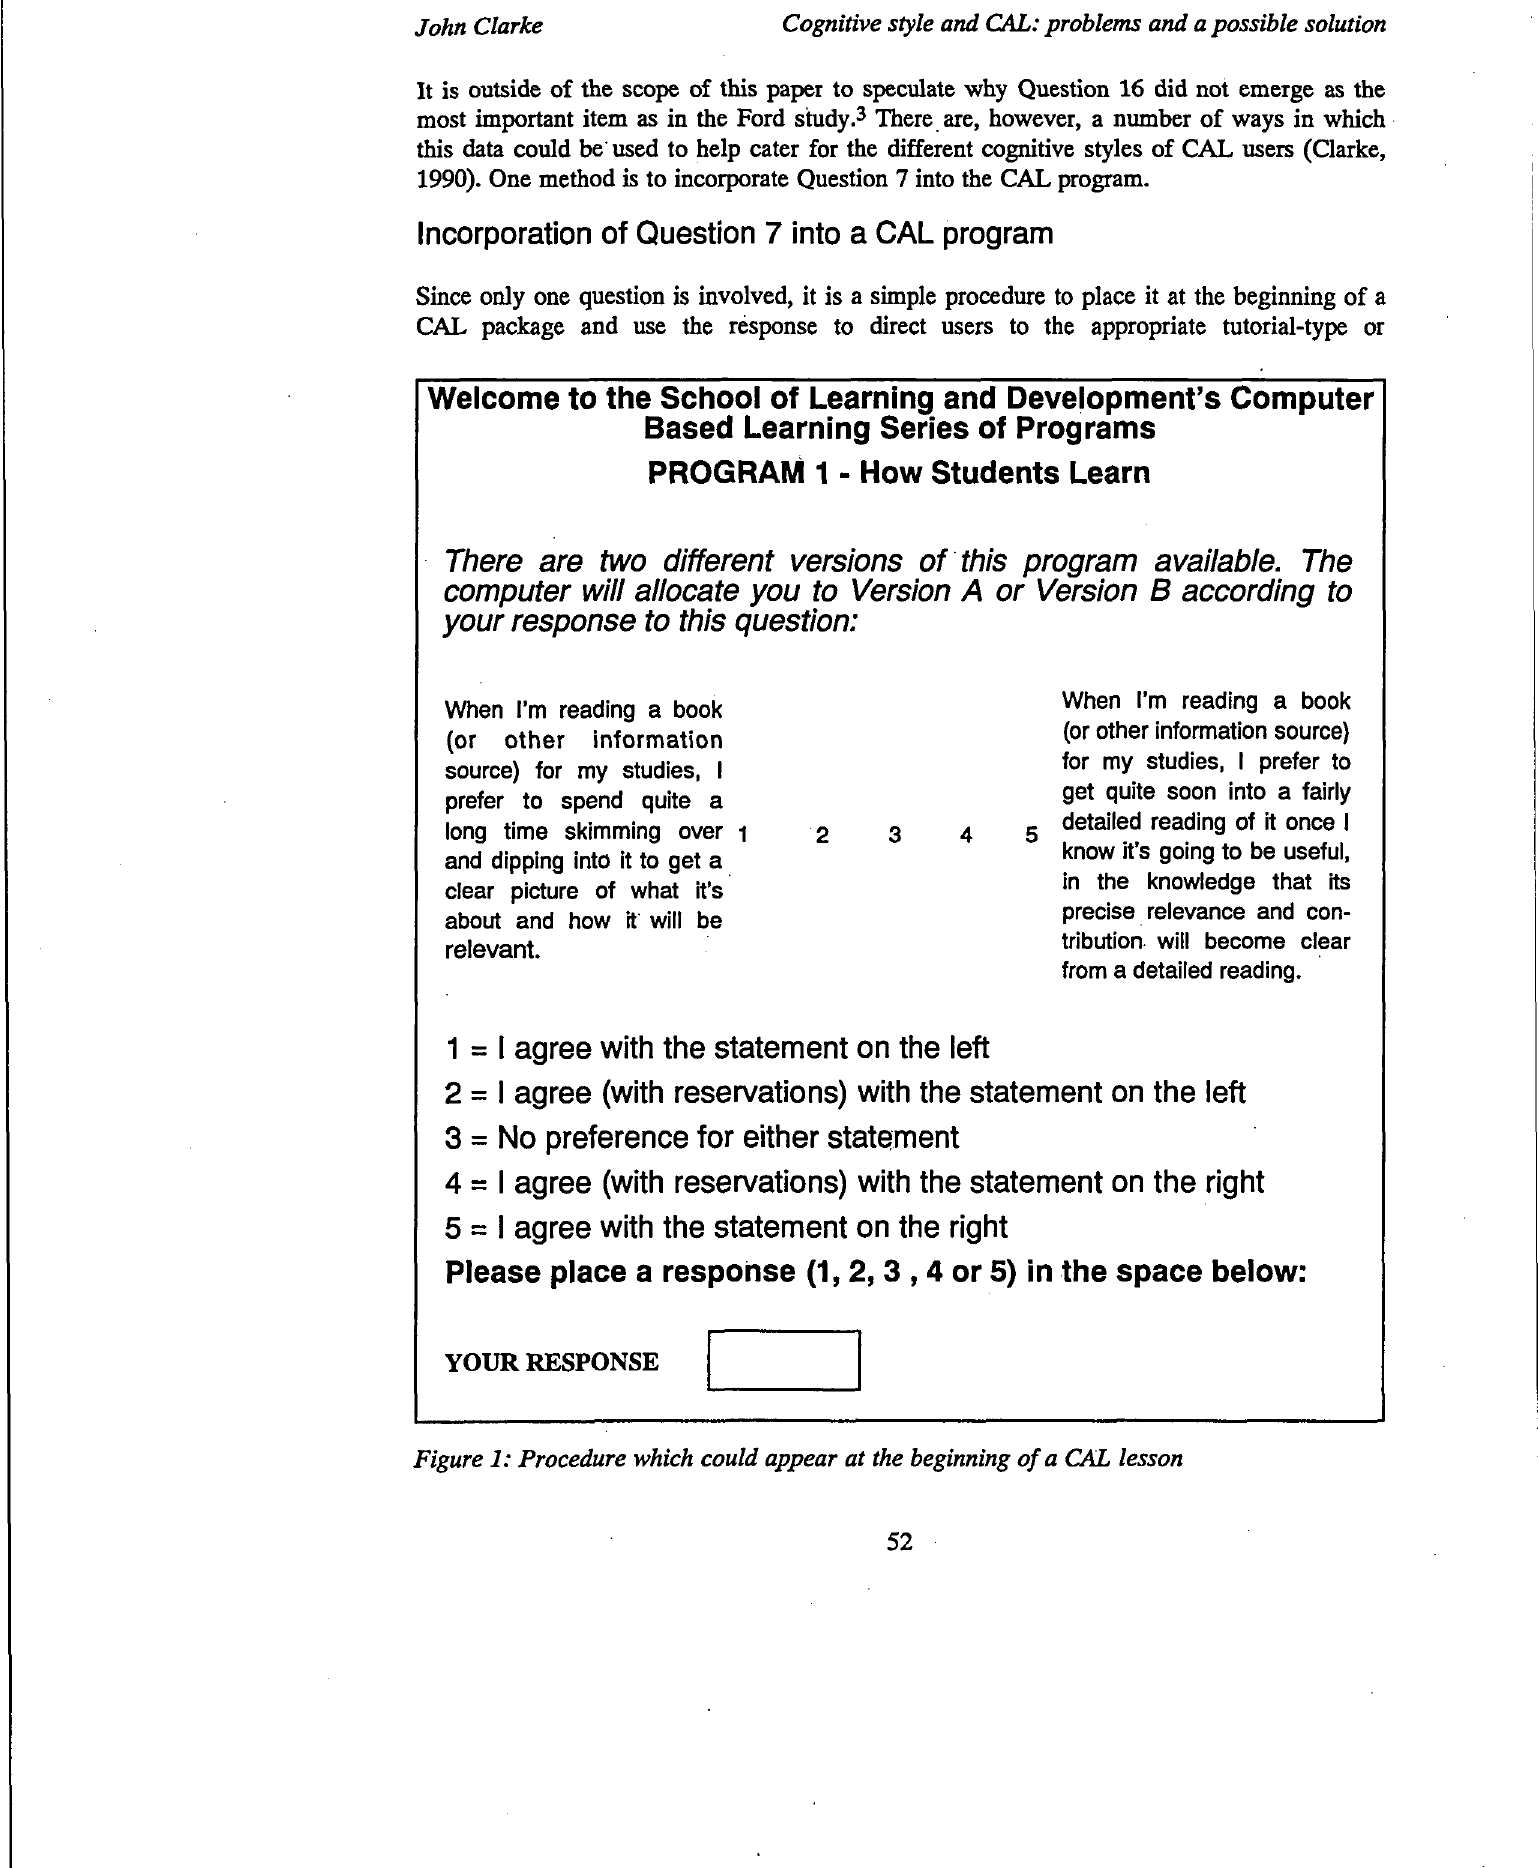
Figure 1: Procedure which could appear at the beginning of a CAL